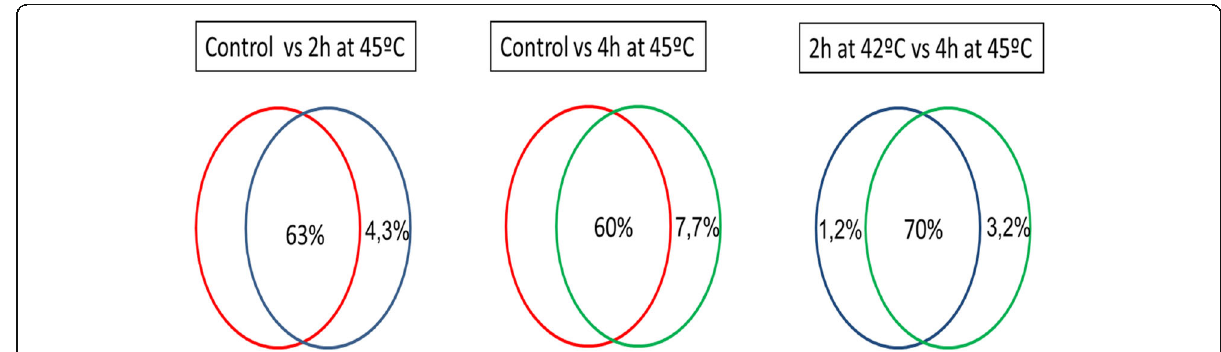
Fig. 3 Venn diagrams show the mean number of matching spots between different sets of contrasting line after gel comparisons using the image master platinum